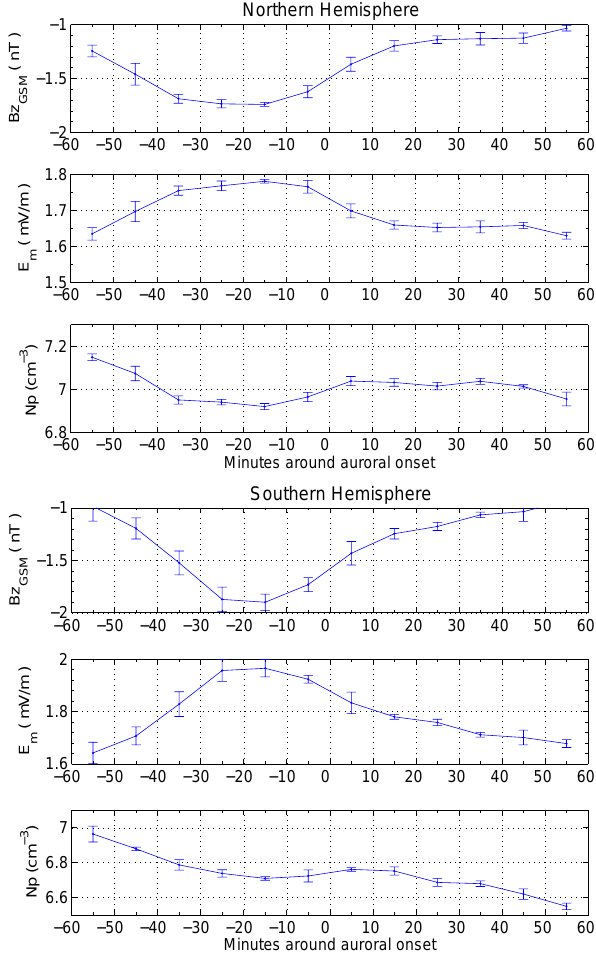
Fig. 2. Superposed epoch analysis of solar wind parameters around auroral breakup. The key time, “0”, corresponds to the onset time. Parameters from top to bottom are IMF B z , merging electric field, E m , and solar wind density, N p , which have been propagated to the dayside magnetopause. The bars indicate the uncertainties of the 10min